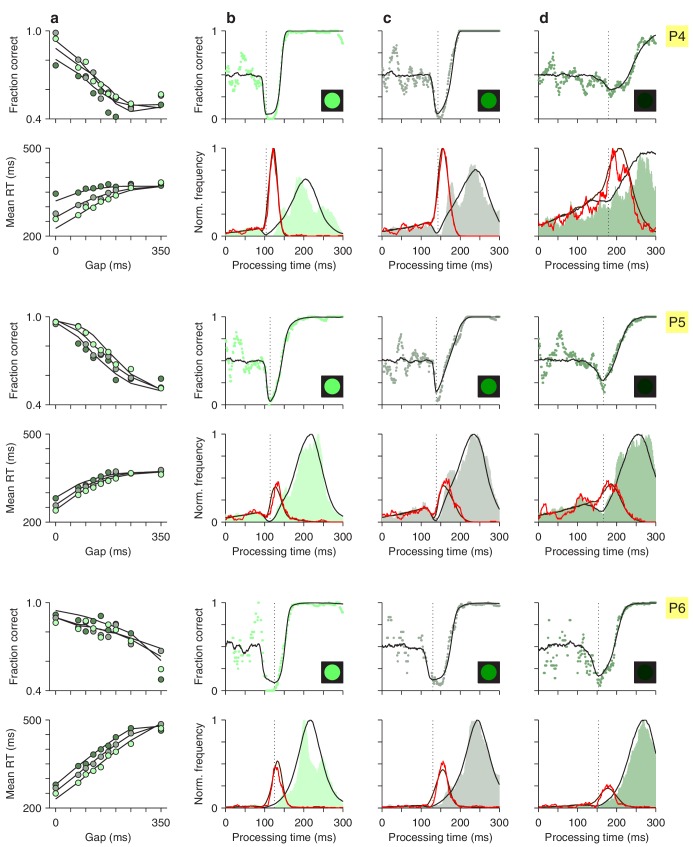
The accelerated race-to-threshold model individually fitted to the data of participants 4 (top two rows), 5 (middle rows), and 6 (bottom two rows).Same format as in Figure 8—figure supplement 2.